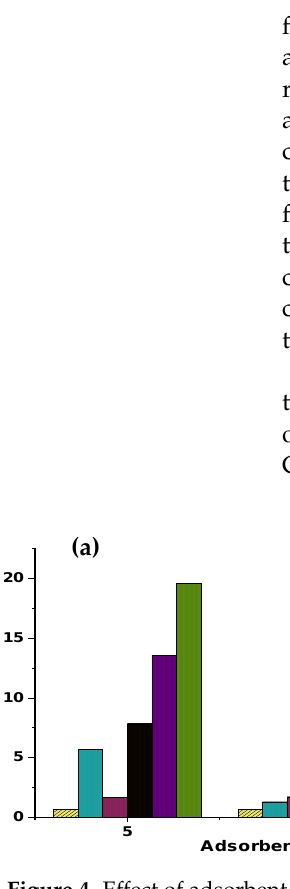
Figure 4. Effect of adsorbent dose and initial concentration on the adsorption capacity of ( a ) tartrazine and ( b ) Congo Red.